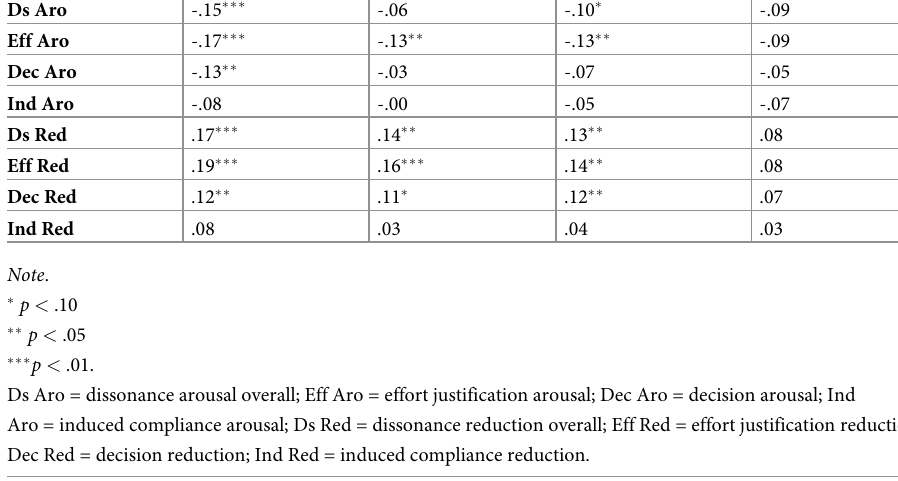
Table 14. Partial correlations of exercise variables with dissonance variables controlling for gender and age (Study 3). Vig days Vig time